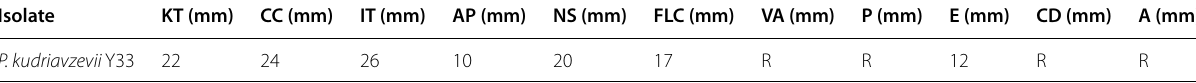
Table 6 Antibiotic susceptibility profile of P. kudriavzevii Y33